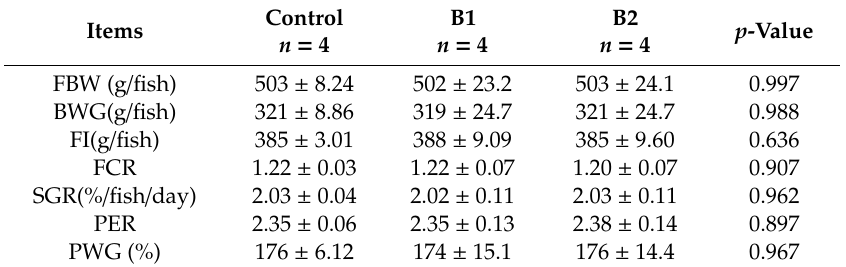
Table 2. The e ff ect of prebiotic Bi 2 tos ® on growth performance of common carp ( Cyprinus carpio L.). Items